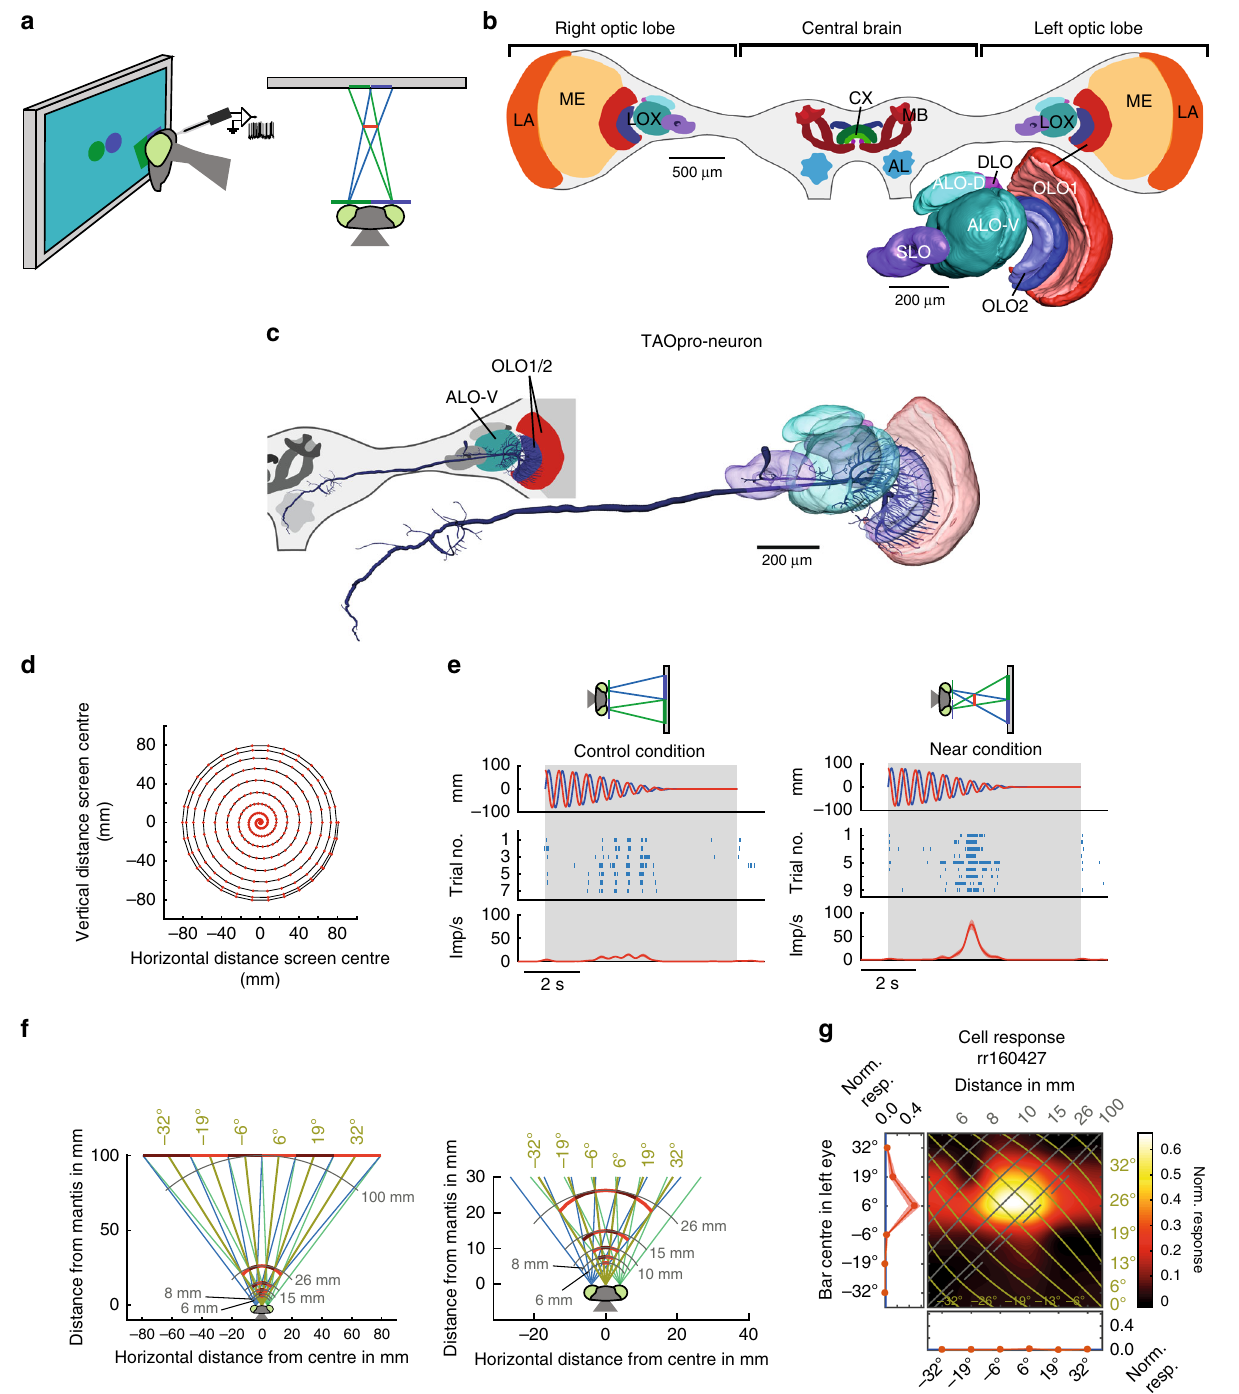
c; beaded terminal neurites in optic lobe — Supplementary Fig. 5)